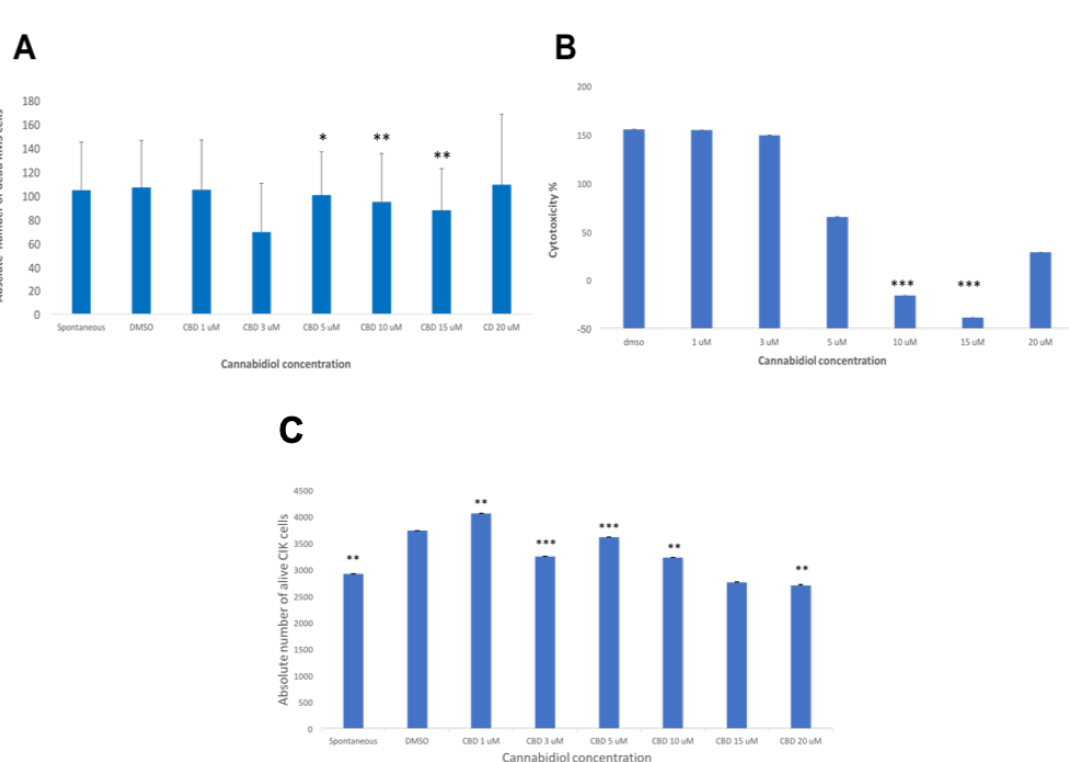
Figure 5. ( A ) The absolute number of dead KMS-12 PE cells was calculated for each sample condition of co-cultured CIKs and KMS-12 PE cells exposed to various concentrations of CBD for 24 h via flow cytometry analysis. The results showed a significant decrease of the absolute number of the dead KMS-12 PE cells at 5 µ M ( p < 0.05), 10 µ M, and 15 µ M ( p ≤ 0.01) compared to the DMSO control. ( B )